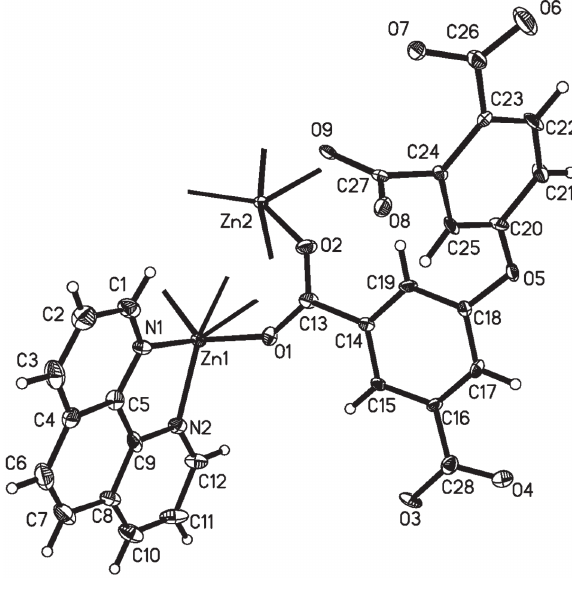
Table 1: Data collection and handling.